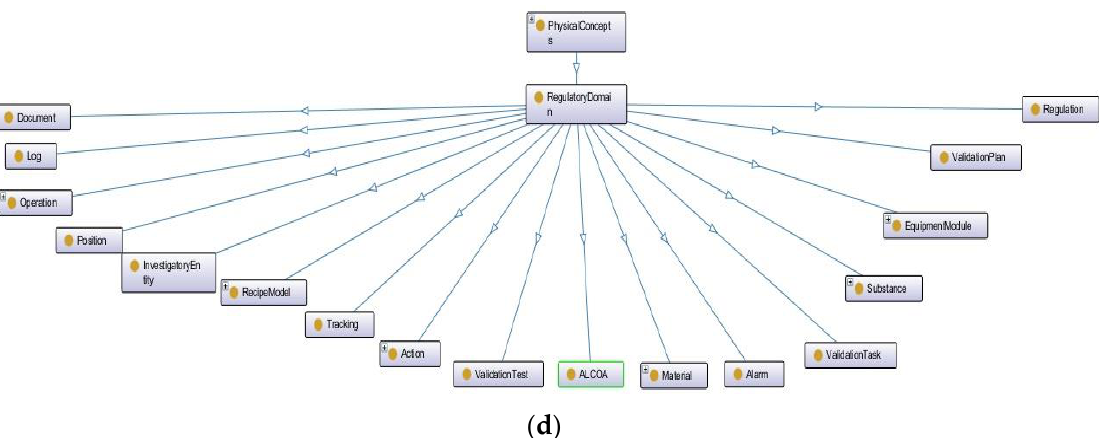
Figure 2. ( a ) Class AbstractConcepts and its subclasses. ( b ) Class ProcessDomain and its subclasses. ( c ) Class ProductDomain and its subclasses. ( d ) Class ProductDomain and its subclasses.